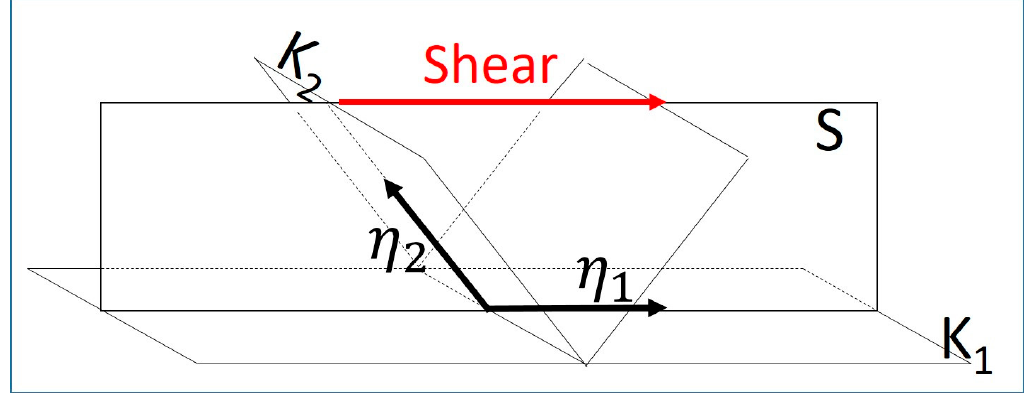
Figure 1. Illustration of twinning elements: K 1 —twinning plane, η 1 —twinning direction, K 2 —conjugate twinning plane , η 2 —conjugate twinning direction .